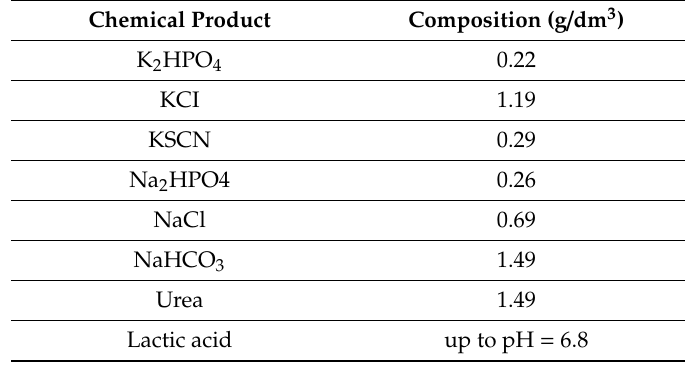
Table 2. Composition of artificial saliva used as an electrolyte for the corrosion